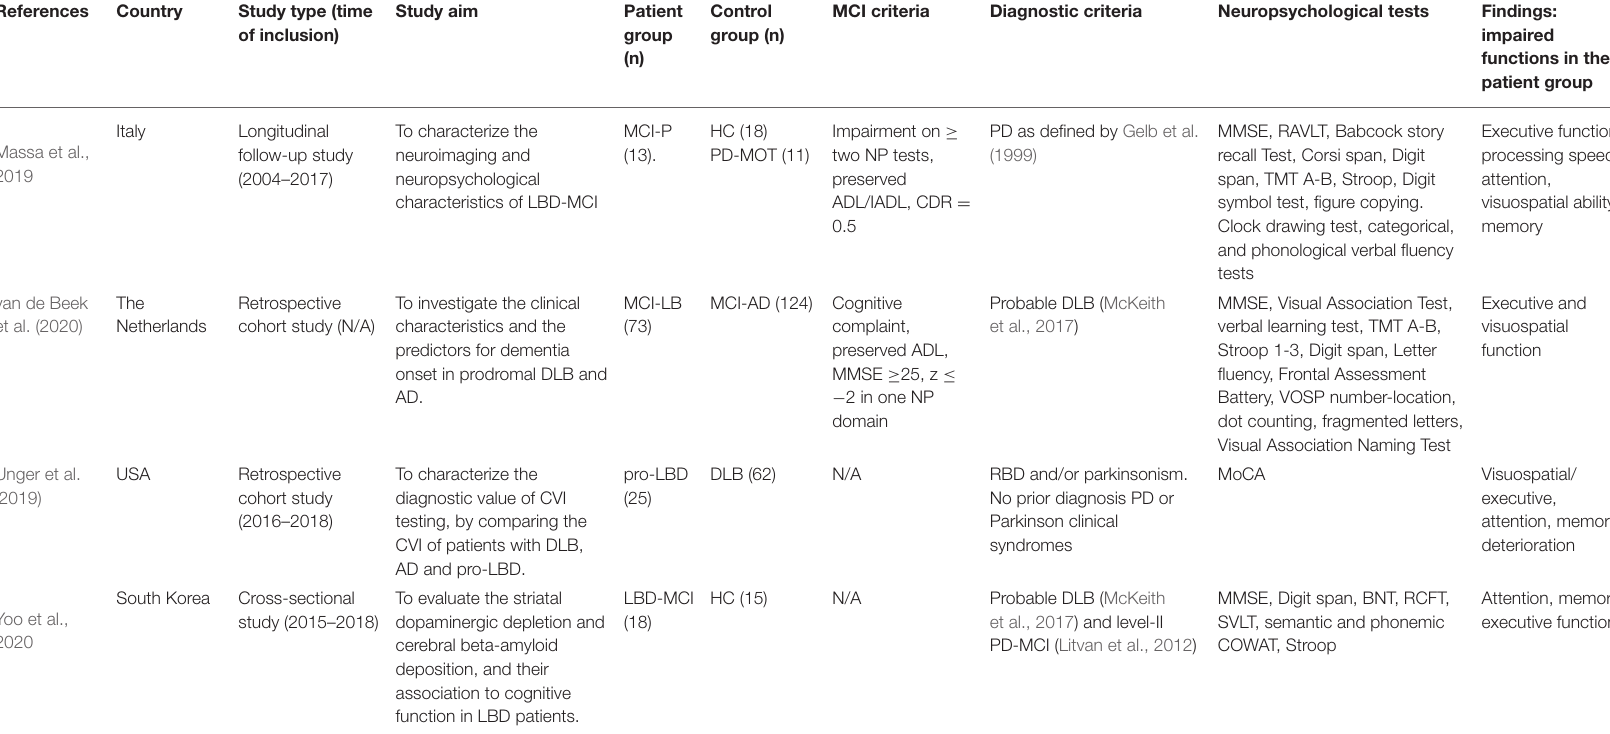
TABLE 1 | Overview of the included